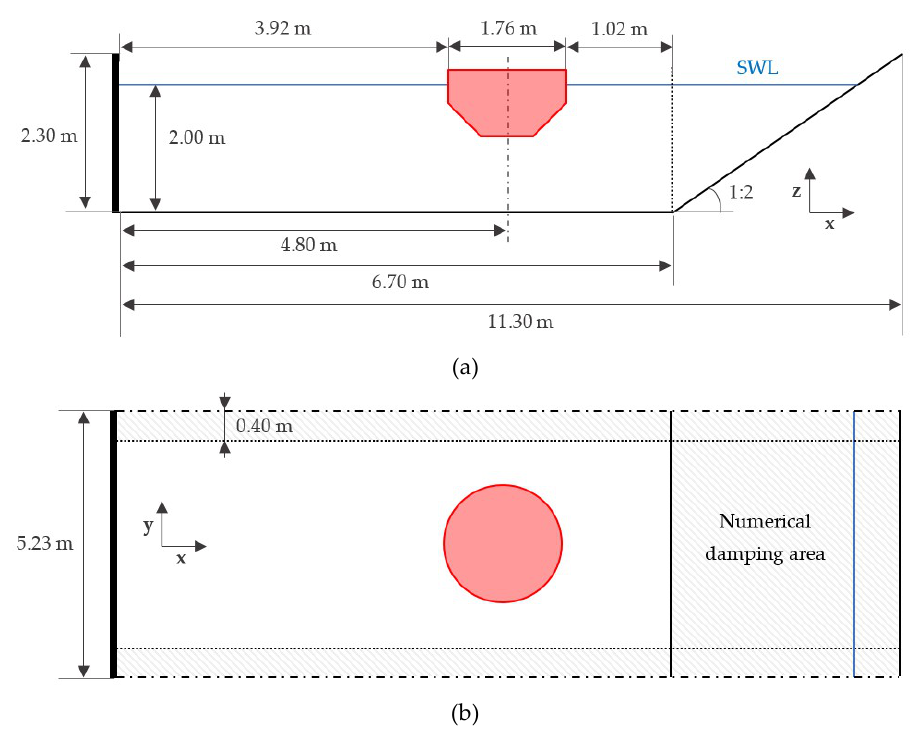
Figure 9. Numerical tank for the static and dynamic response test: ( a ) lateral view; ( b ) top view.